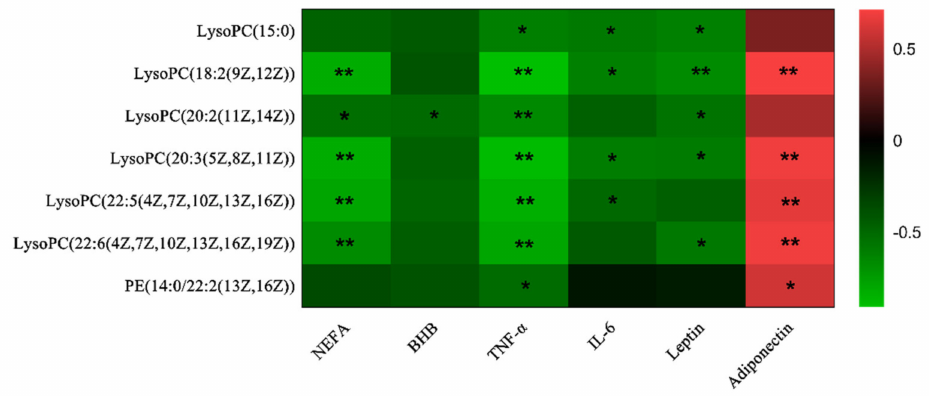
Figure 4. Correlations between plasma classic metabolic parameters and di ff erential metabolites in cows with di ff erent calving body condition score. Red represents a positive correlation, while green represents a negative correlation. “**” and “*” in the figure means that the value of p < 0.01 and < 0.05,